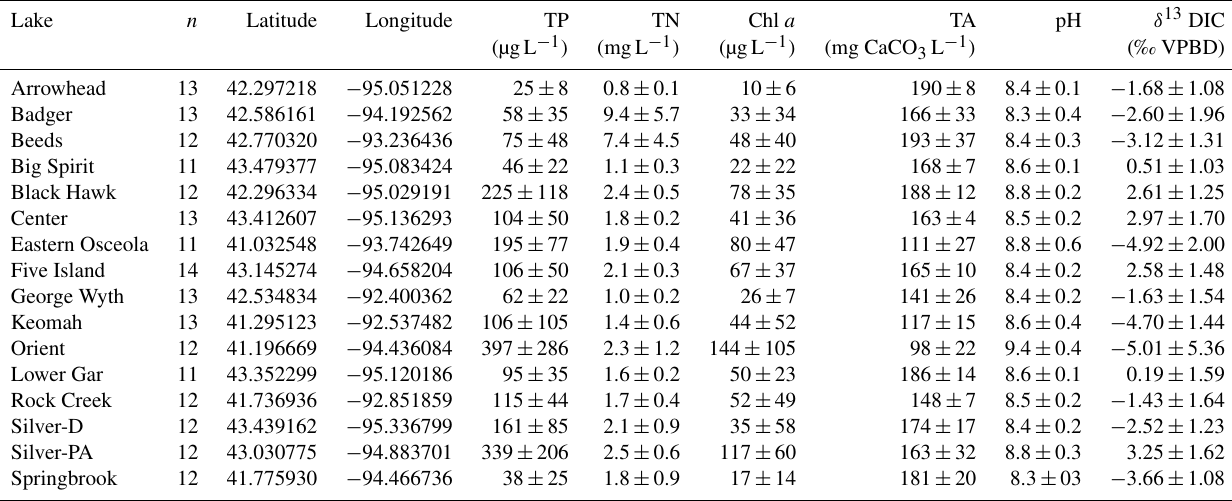
Table 1. Summary data for lakes included in this study. Total phosphorus (TP), total nitrogen (TN), chlorophyll a (Chl a) , total alkalinity (TA), pH, and δ 13 DIC are reported as average values of all sampling events (ice-free season, April–November 2012) ± SD; n represents the number of observations per lake.